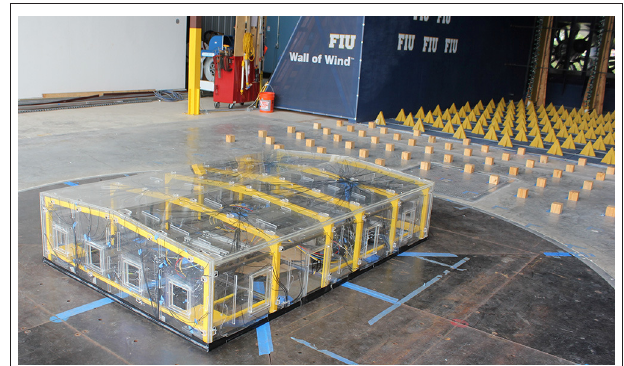
FIGURE 3 | 1:8 model constructed at